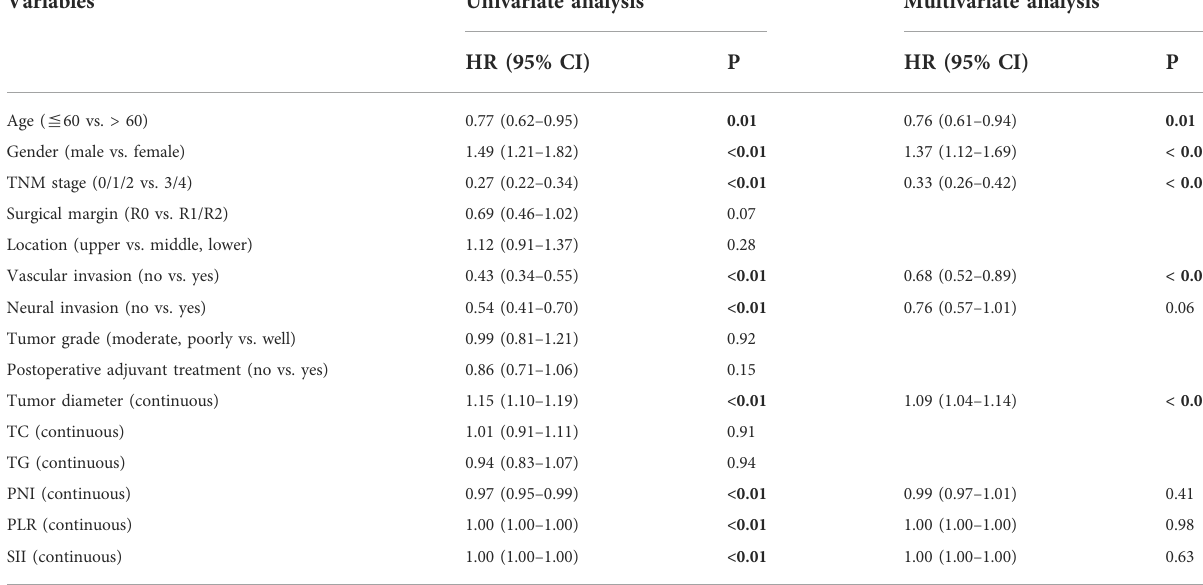
TABLE 4 Univariate and multivariate analysis of overall survival in the matching cohort.